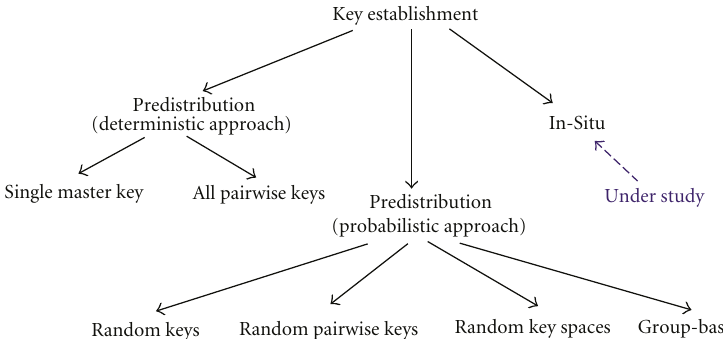
Figure 1: Existing Key Establishment Schemes - A